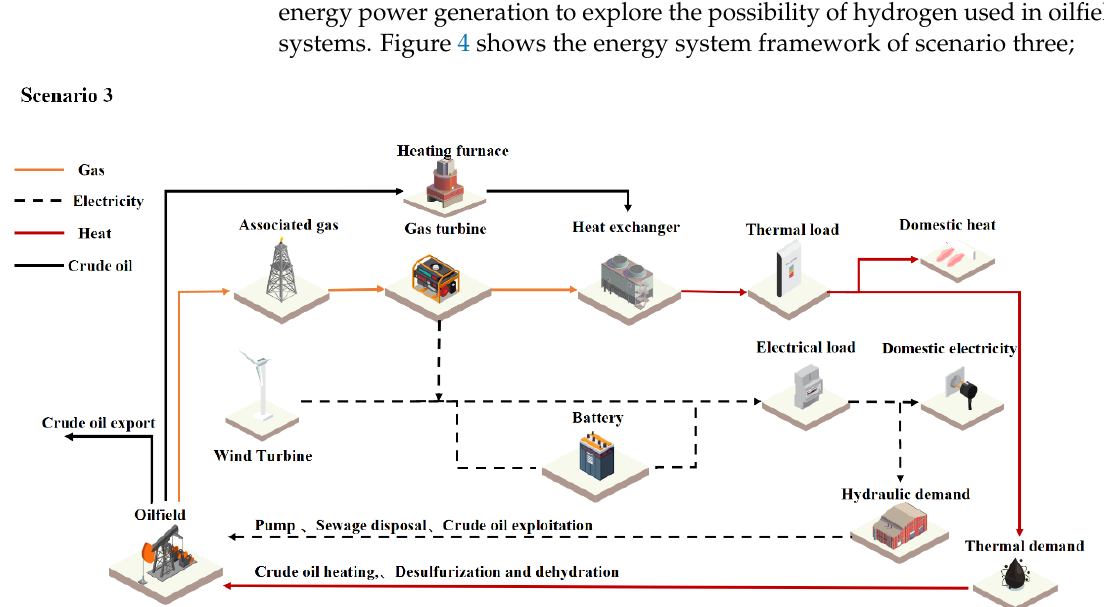
Figure 4. The oilfield energy system framework of scenario 3. (4)